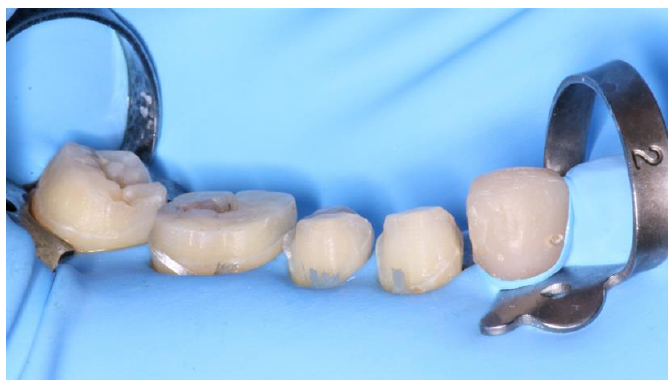
Figure 12. Installation of a rubber dam.